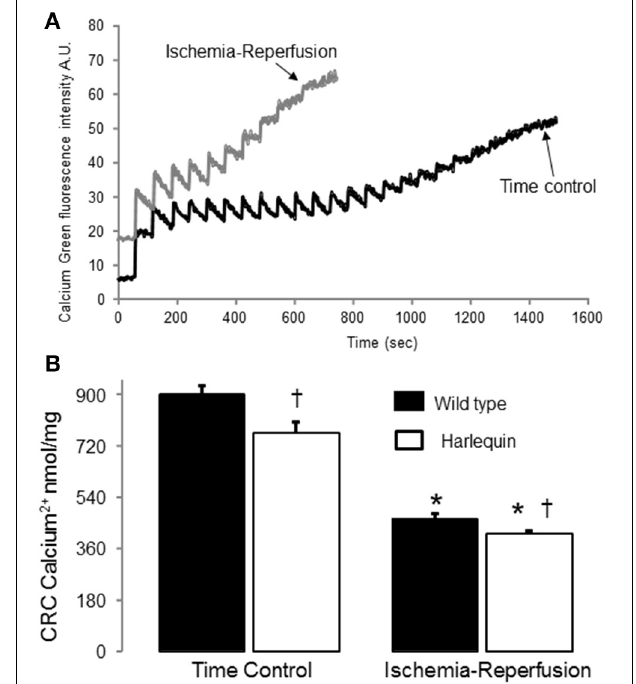
FIGURE 3 | IR decreased the CRC in wild type and Harlequin cardiac mitochondria. Original tracings of CRC measurement in wild type heart mitochondria were shown in panel (A) . The CRC was decreased in control Harlequin mouse heart mitochondria compared to wild type (B) , suggesting that the sensitivity to MPTP opening was increased in Harlequin mice in the basal condition. IR led to decreased CRC in both wild type and Harlequin mice compared to time control (B) . Compared to wild type, IR led to a slight further decrease in CRC in Harlequin mice (B) . Data are expressed